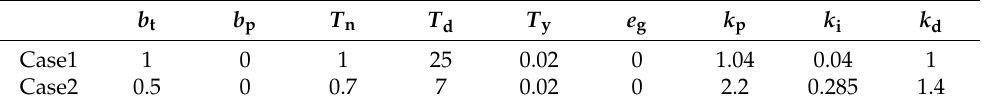
Table 2. Regulating parameters for the start-up